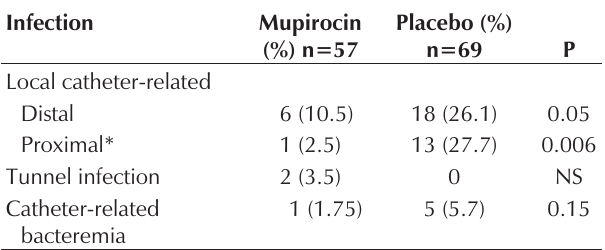
Episodes of local catheter-related infection (15 colony form- ing units or more on semiquantitative culture) in patients re- ceiving either mupirocin or placebo at the catheter exit